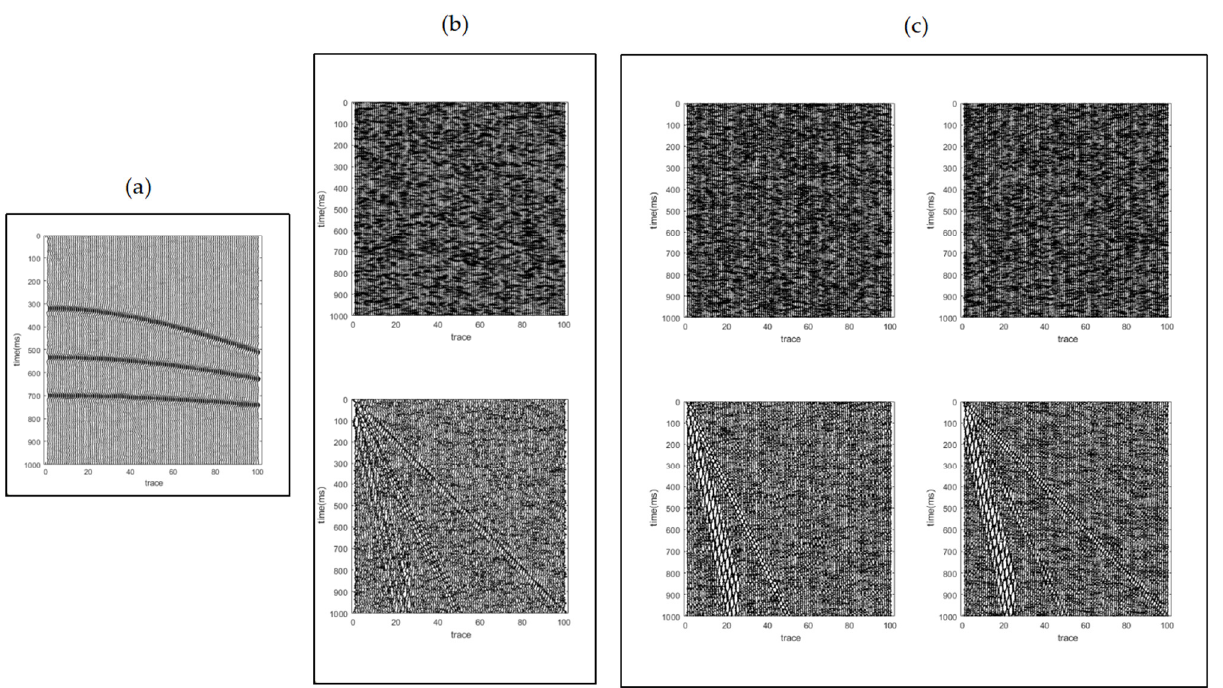
Figure 5. The NSST coefficients after the decomposition of the NSST. ( a ) The approximate NSST coefficients. ( b ) The detail NSST coefficients at scale 2, 2 directions. ( c ) The detail NSST coefficients at scale 1, 4 directions.